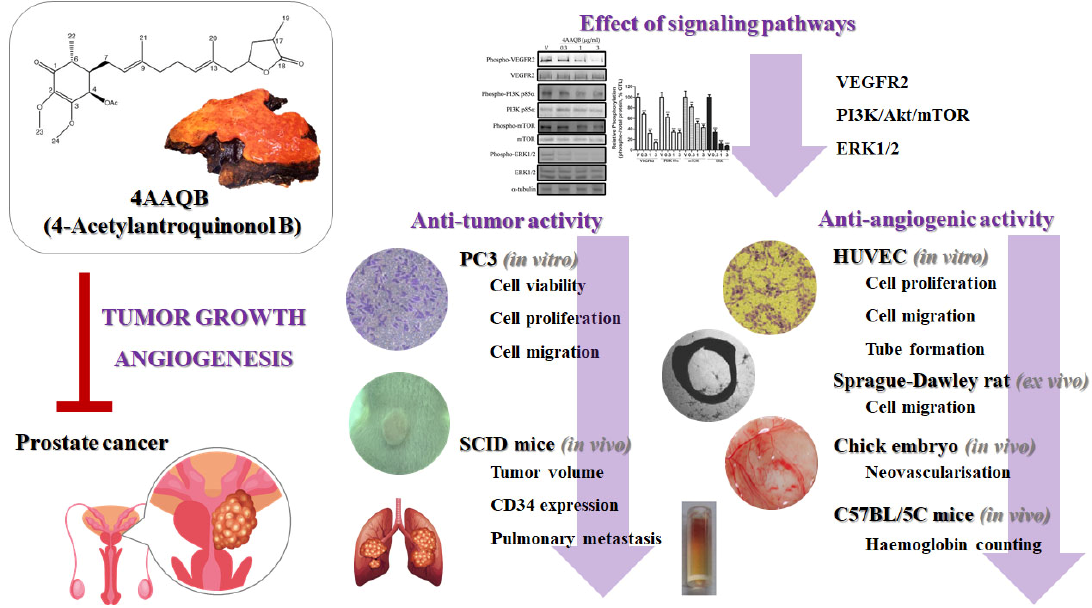
Figure 8. 4AAQB inhibits cancer growth and angiogenesis via a VEGF/PI3K/mTOR/ERK-dependent signaling pathway.